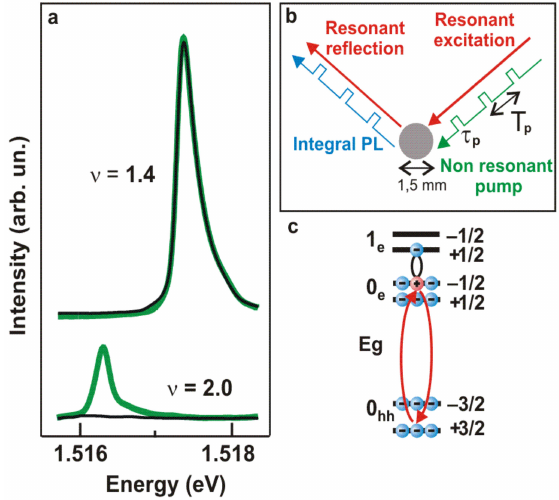
Figure 1. ( a ) PRR spectra of a 2DES (sample 1) in the state of a Hall conductor, ν = 1.4, and a Hall insulator, ν = 2.0, with (green curves) and without (black curves) non-equilibrium spin excitations. ( b ) The diagram of the experimental setup with a double-fiber technique. ( c ) The optical transition scheme for PRR. The zero and the first Landau levels for electrons in the conduction band of an GaAs/ AlGaAs quantum well are designated by 0 e and 1 e , respectively. The zero Landau level for heavy holes is denoted by 0 hh